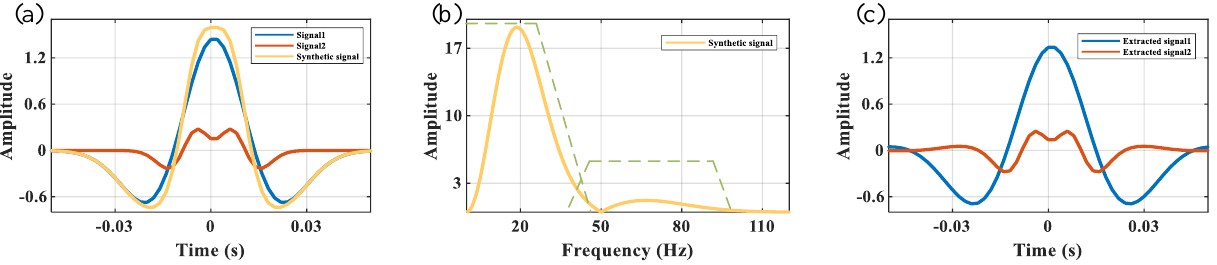
Figure 1. Schematic diagram of multi-scale seismic data extraction. ( a ) Synthesized seismic signal. ( b ) The amplitude spectrum of the synthesized signal, where the dashed green line indicates the crossover window. ( c ) The extracted multi-scale seismic data.